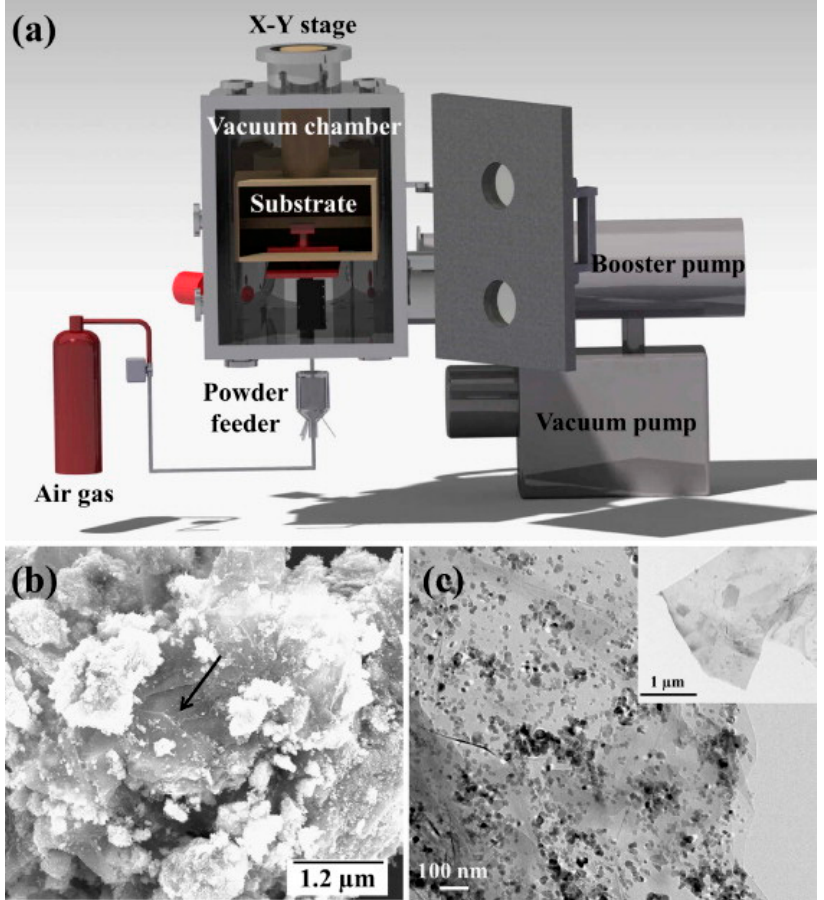
Figure 10. Schematic diagram of the AD experiment and the results obtained. Part ( a ) shows the air gas tank, powder feeder, nozzle, vacuum chamber, and pumps, parts ( b ) and ( c ) show the SEM and TEM images of the TiO 2 /G nanocomposite. Reprinted with permission from reference [144]. Copyright 2014 Elsevier.